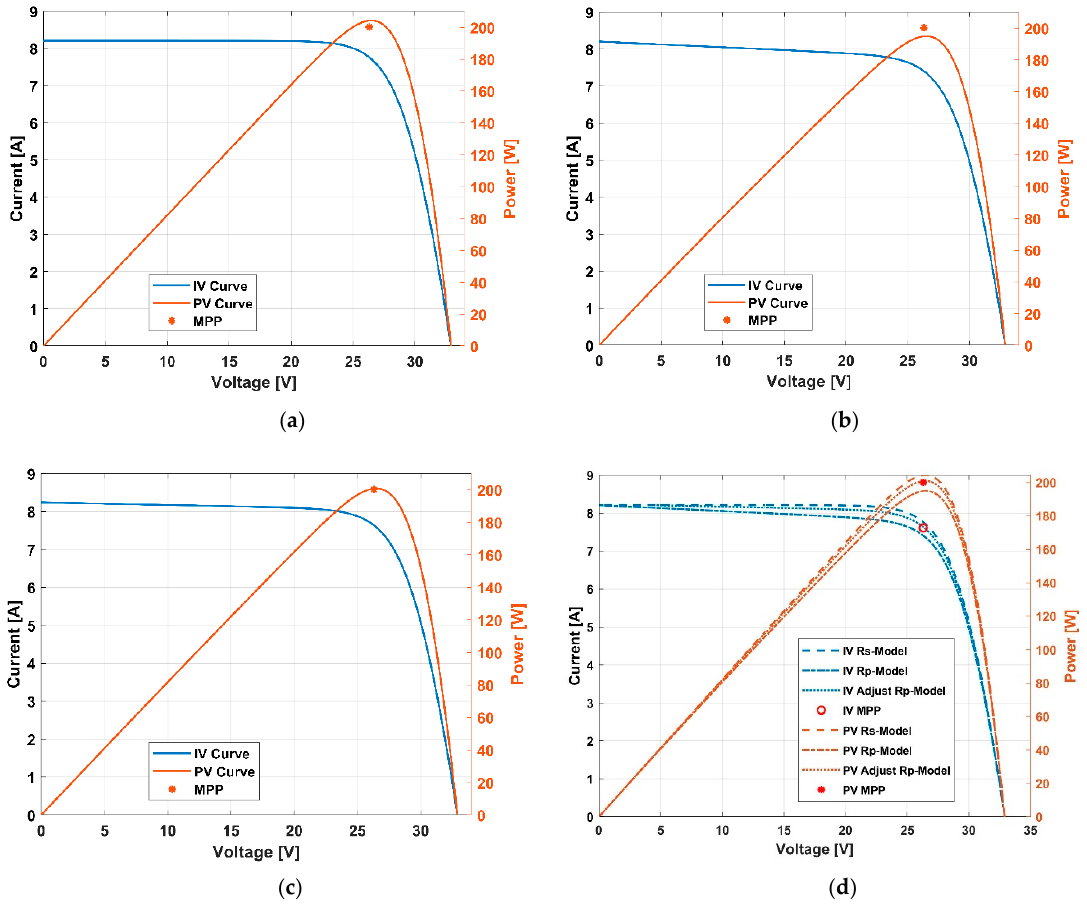
Figure 4. Estimated phases of the output data of the proposed method of the KC200GT panel: ( a ) Step 1 Rs-model; ( b ) Rp-model; ( c ) Step 2 Optimized Rp-model; ( d ) Comparison of all the phases.